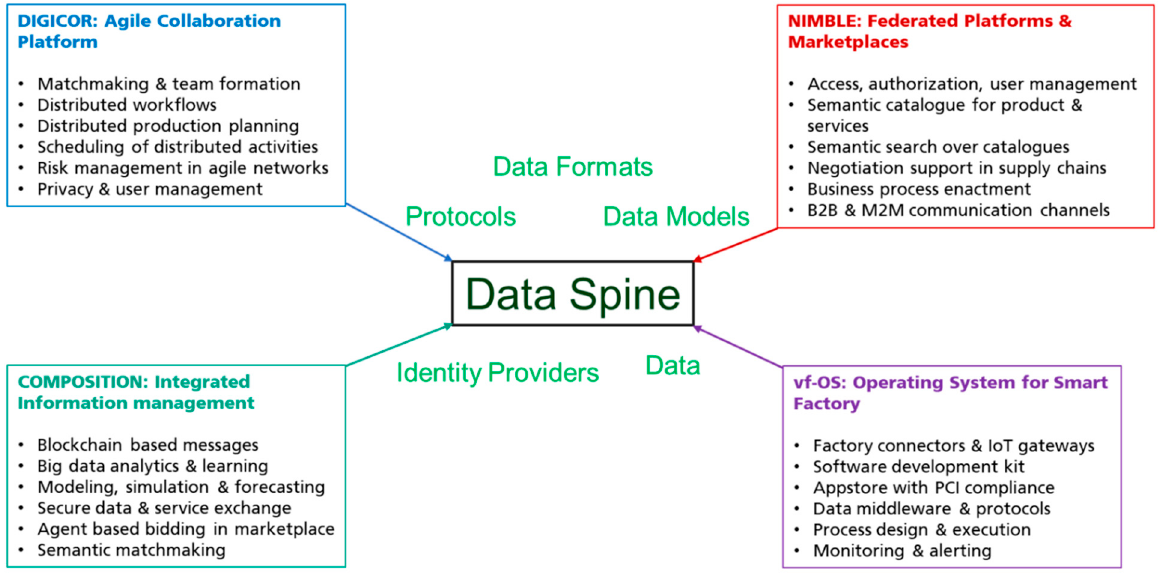
Figure 2. Conceptual overview of the EFPF (European Factory Platform) ecosystem.